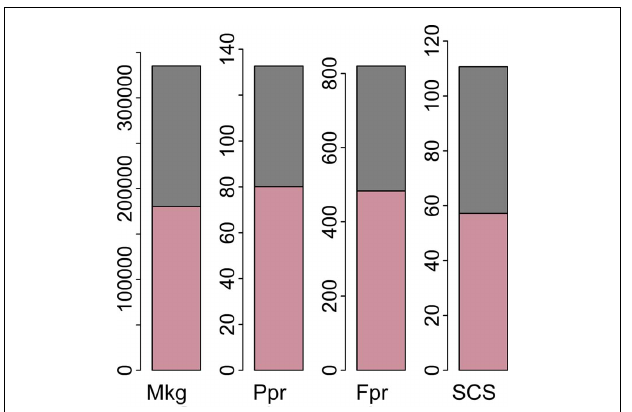
FIGURE 6 | Sums of variances (pink) and covariances (grey) between predicted chromosomal breeding values. Traits are milk yield (Mkg), protein percentage (Ppr), fat percentage (Fpr), and somatic cell score (SCS).